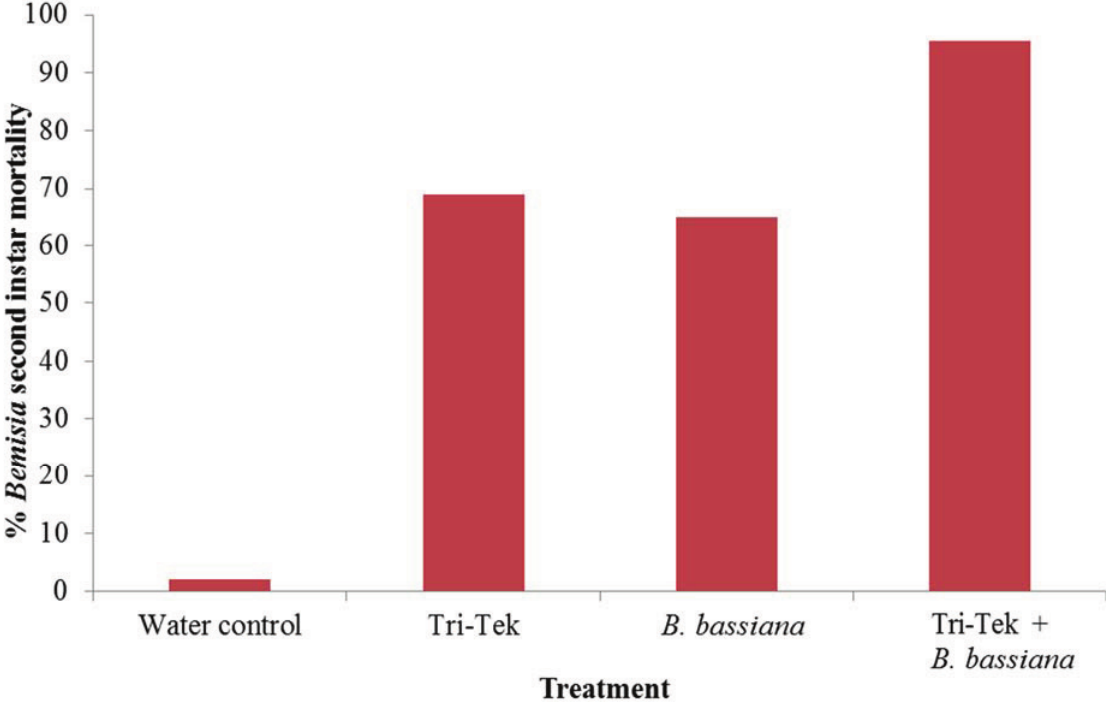
Figure 3. Efficacy of products against Bemisia tabaci Mediterranean second instar larvae. Mortality recorded after two days following treatment with Tri-Tek and after seven days following Beauveria bassiana